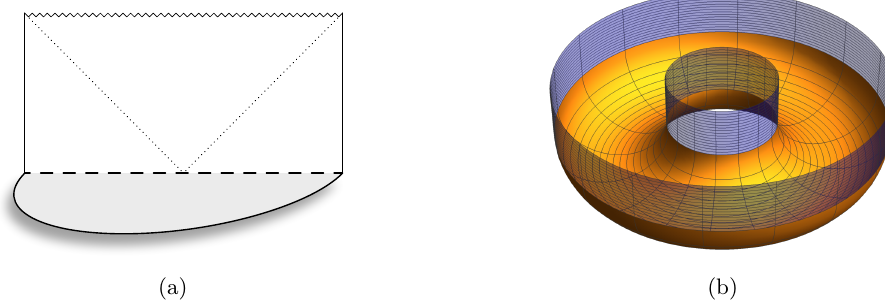
Figure 1 . The AdS 3 HH State and the Dual TFD . The conformal diagram of the asymptotic AdS 3 two-sided black hole (or, rather, its top half) is shown on the left. Over each point is an additional circle, which is suppressed in the figure. The left and right asymptotic AdS 3 regions are causally separated by the horizons, represented by the diagonal dotted lines. The future singularity is the zigzag line at the top of the diagram. The Hartle-Hawking state is prepared by halving the Euclidean continuation of the black hole, shown by the half-disk, and gluing it to the zero-time slice of the black hole on the horizontal dashed line. The Euclidean time periodicity is β , the inverse Hawking temperature of the black hole. The zero-time slice has the topology of an annulus and the halved Euclidean black hole resembles a half-bagel, obtained by revolving the dashed line and half-disk around the suppressed circle. Above the Hawking-Page temperature, this bulk state is dual to the thermofield-double state in two copies of the boundary CFT on a circle (times time), shown on the right. The yellow half-torus prepares the state on its two circle boundaries, which then evolve forward in Lorentzian time along the two blue cylinders. The Hartle-Hawking cap that prepared the bulk state corresponds to the solid half-torus obtained by filling in the interior of the yellow